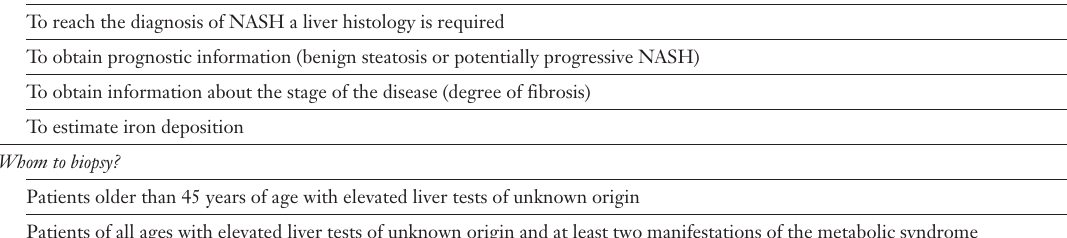
Evidence justifying a liver biopsy in pa- tients with suspected